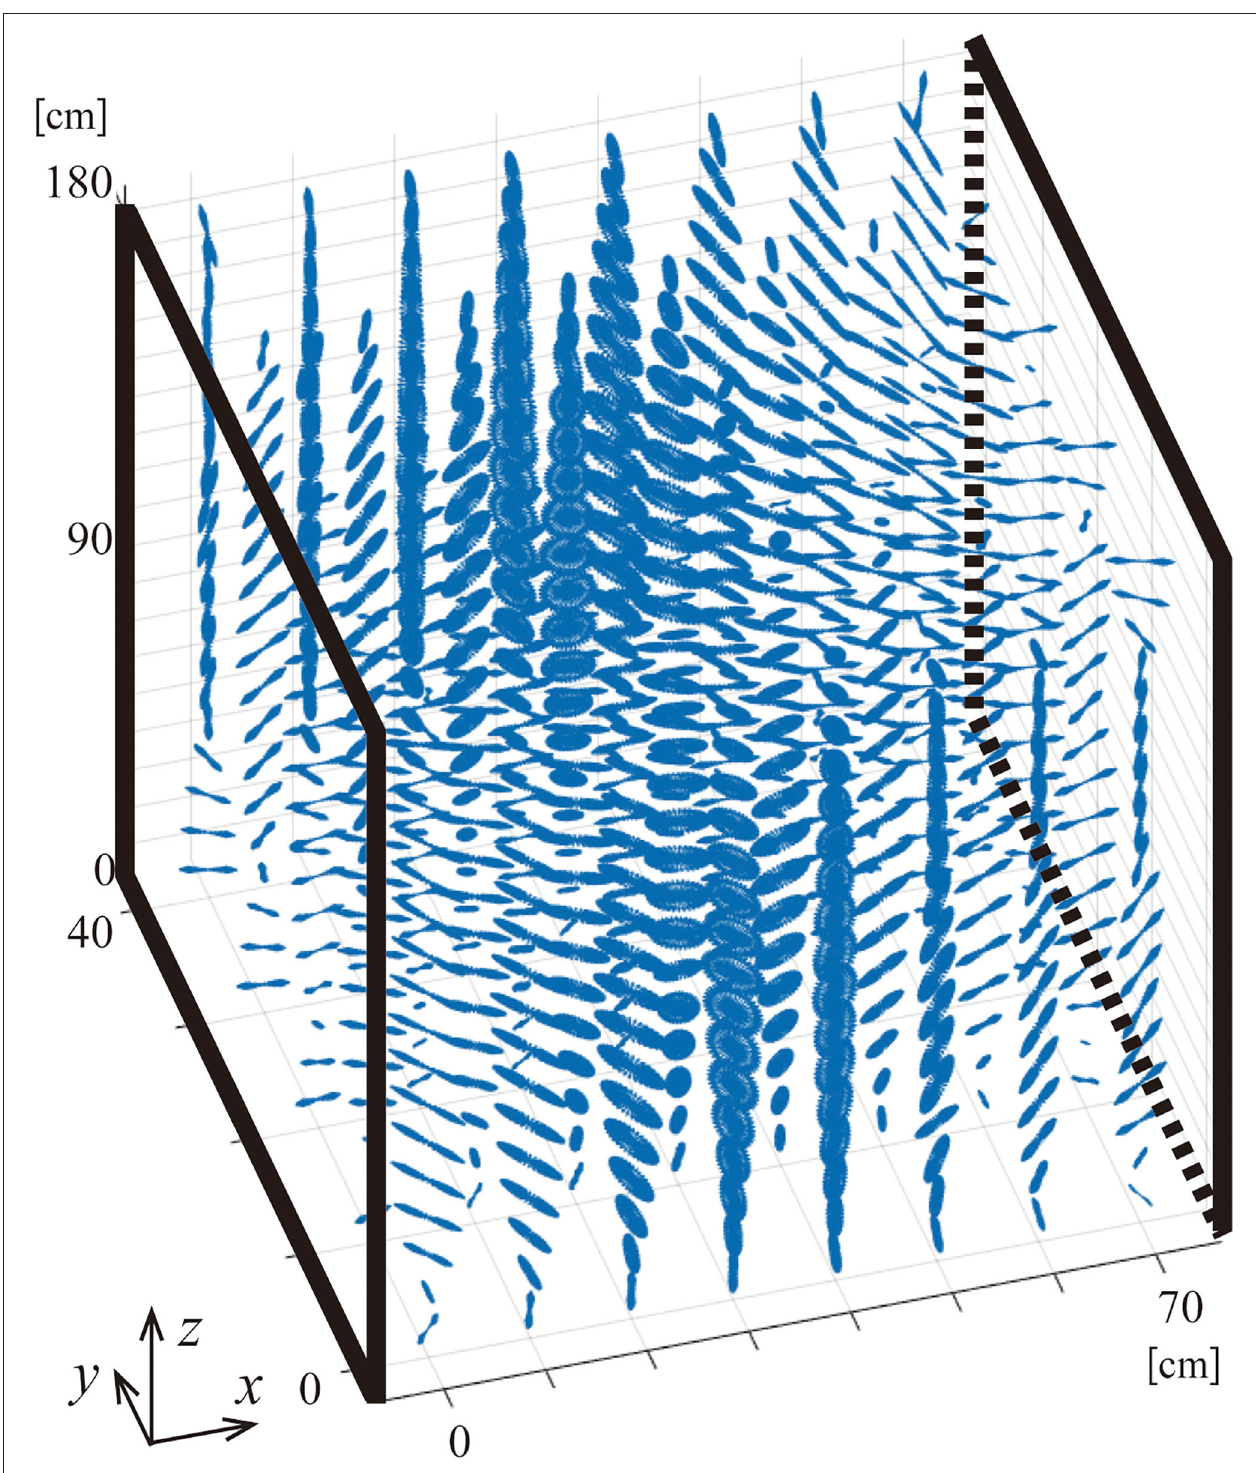
FIGURE 4 | Illustration of elliptical rotation of magnetic field vectors in the gate aisle of G1. The scales in each direction of x, y, z are not the same to clarify the distribution of rotations.